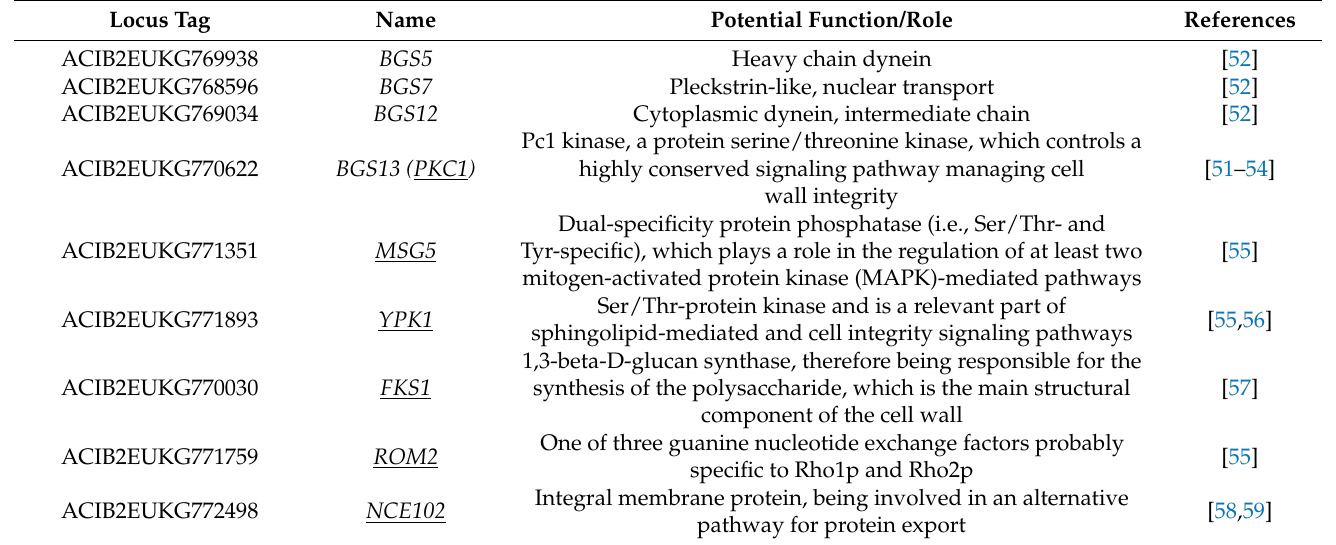
Table 1. Overview of genes targeted in the single target CRISPR/Cas experiments. “Name” denotes the gene names used in this study and are underlined if they relate to the homologous gene in Saccharomyces cerevisiae